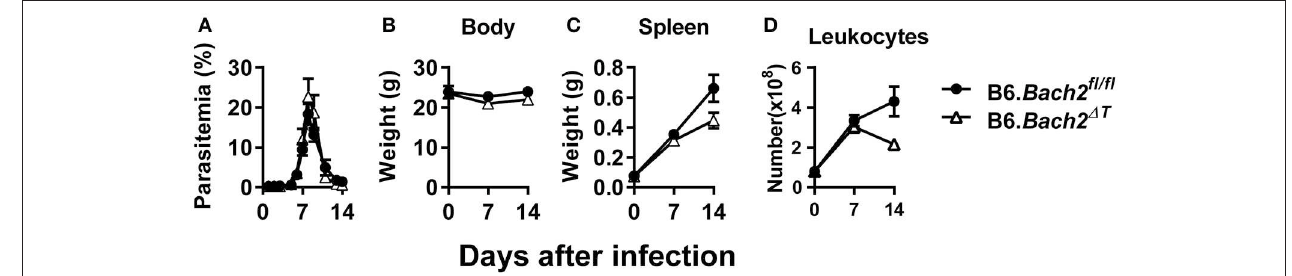
FIGURE 2 | T cell-specific BACH2 does not influence disease outcome in P. chabaudi infection. (A) Blood parasitemia was measured on days 1–8 p.i. ( n = 12 mice per group), and days 9–14 p.i. ( n = 6 mice per group). Whole body weights (B) , spleen weights (C), and numbers of splenic leukocytes (D) were measured in